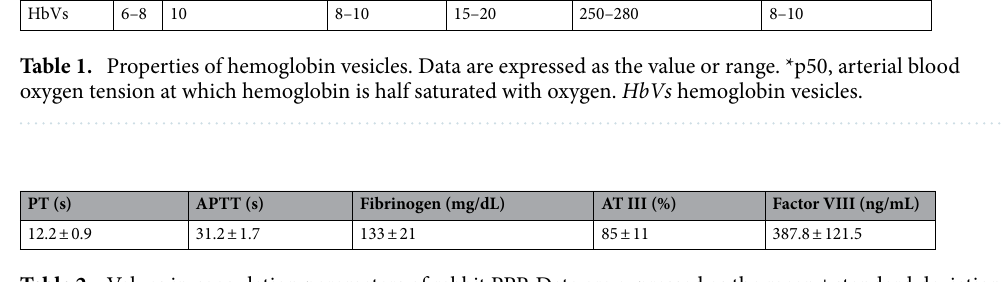
Table 2. Values in coagulation parameters of rabbit PPP. Data are expressed as the mean ± standard deviation.